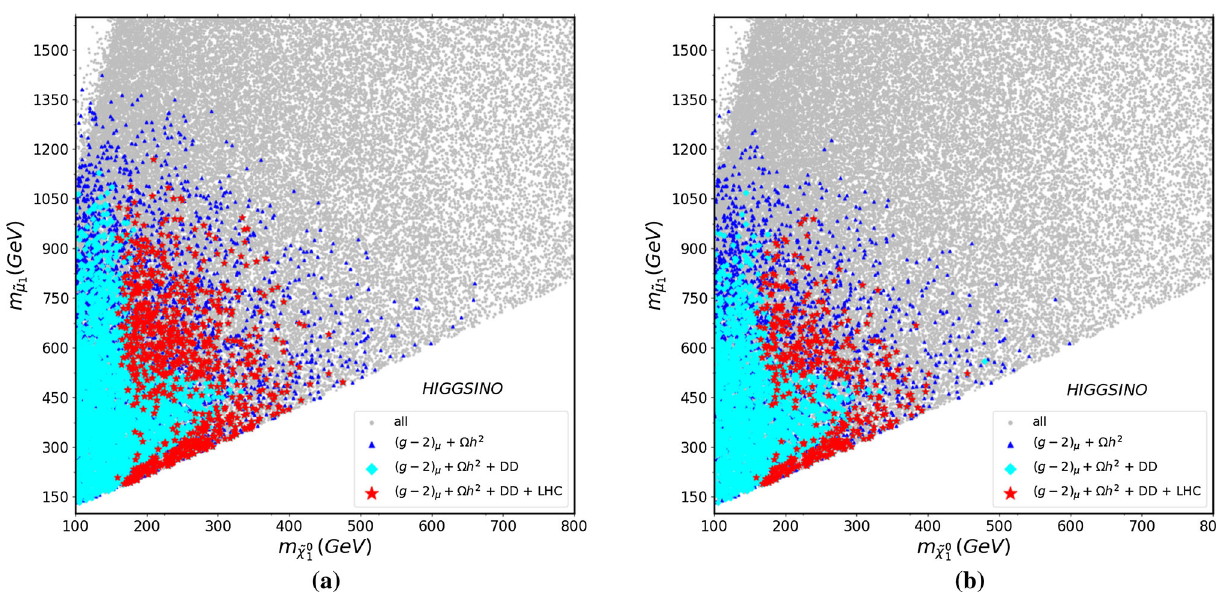
Fig. 4 The results of our parameter scan in the m ˜ χ 0 from ( g − 2 ) μ . The color coding is as in Fig. 1